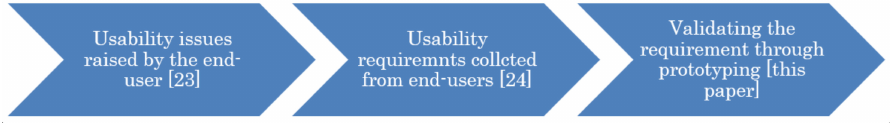
Figure 1. This paper is built on the existing